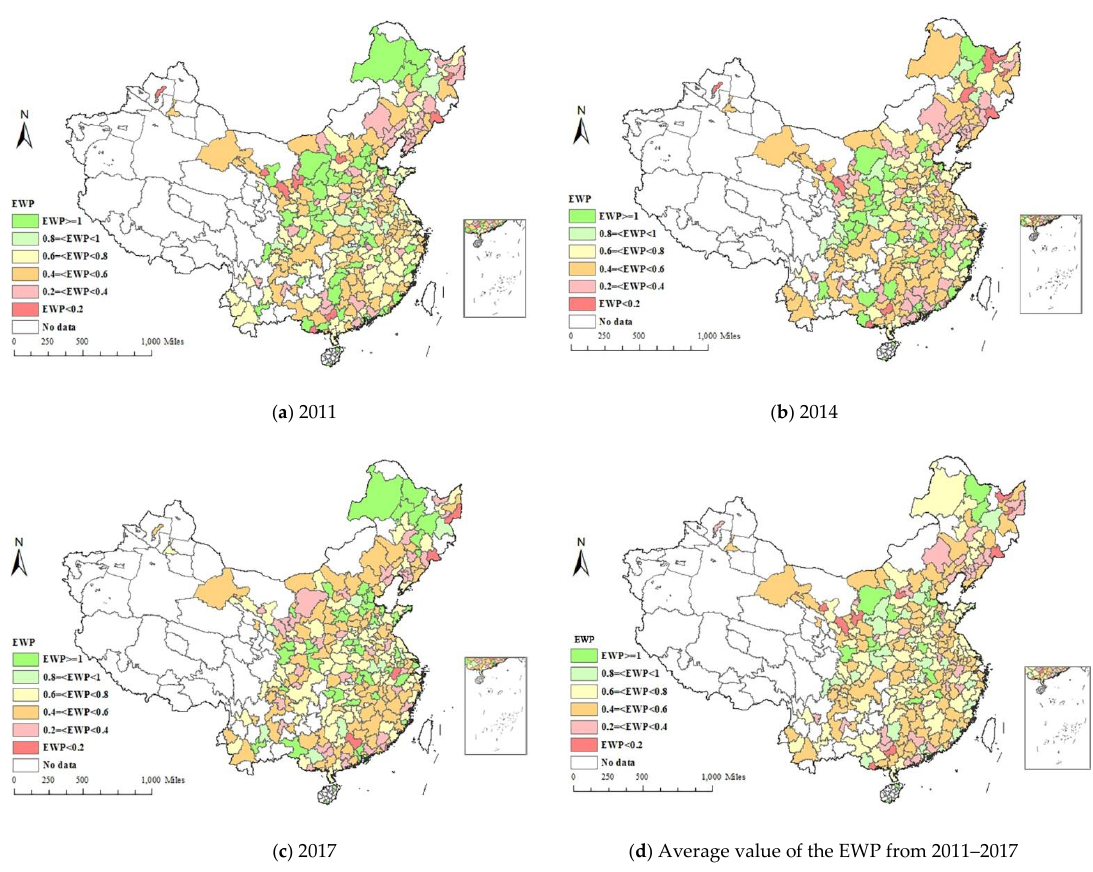
Figure 4. The EWP in Chinese eastern, central, western region and whole China from 2011–2017.